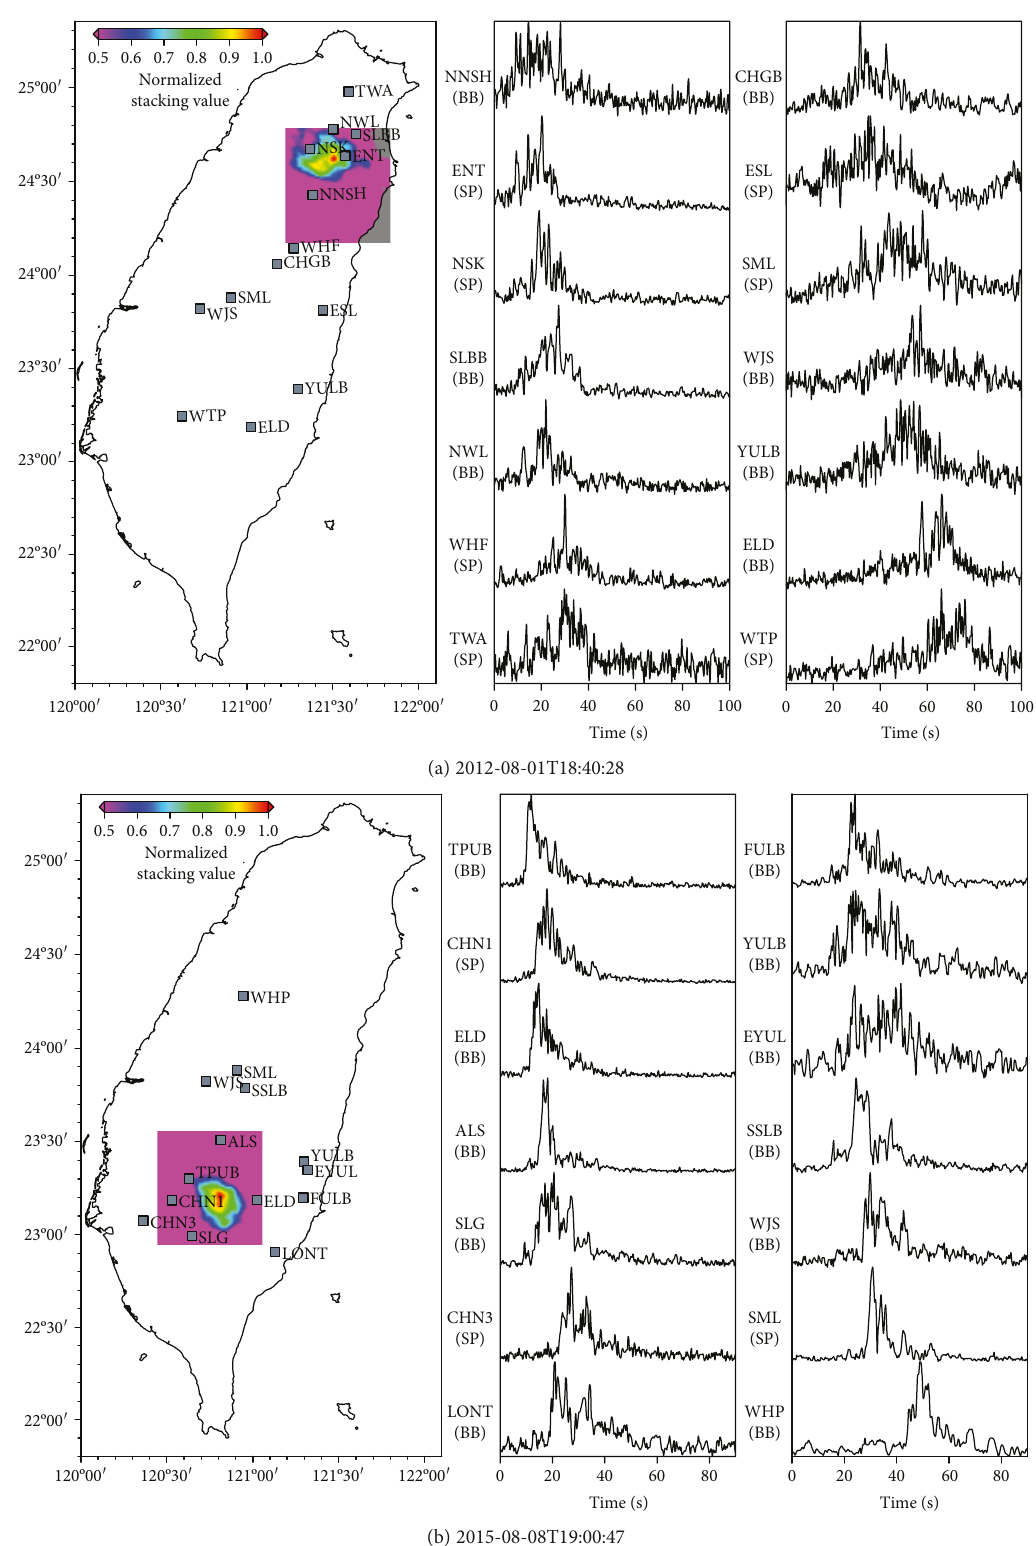
Figure 7: Two examples of landslide relocation results during the 2012 Typhoon Saola (a) and the 2015 Typhoon Soudelor (b). The maps show the optimal locations determined by the back projection method. The 1 ~ 3 Hz RMS envelopes of broadband and short-period recordings used in the back projection are displayed on the right of each